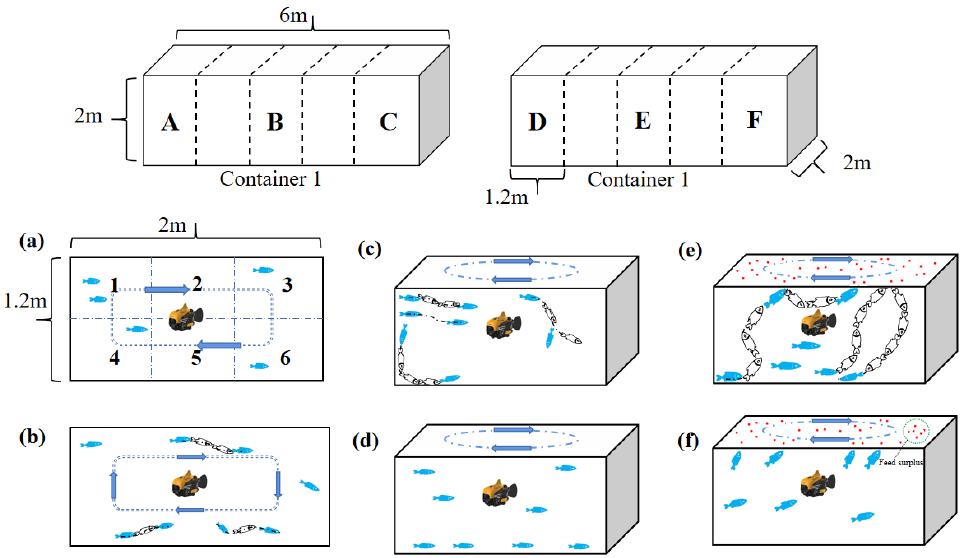
Figure 2. Schematic diagram of the setup for experiment two. ( a ) Regional location; ( b ) Behavioral activity; ( c ) Location in the water body; ( d ) Abnormal movement; ( e ) Response time; ( f ) Food consumption.